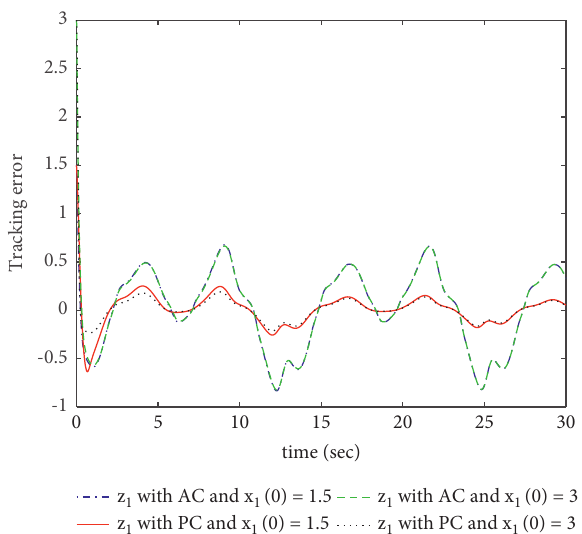
Figure 6: The comparison of tracking errors between PC and AC with y